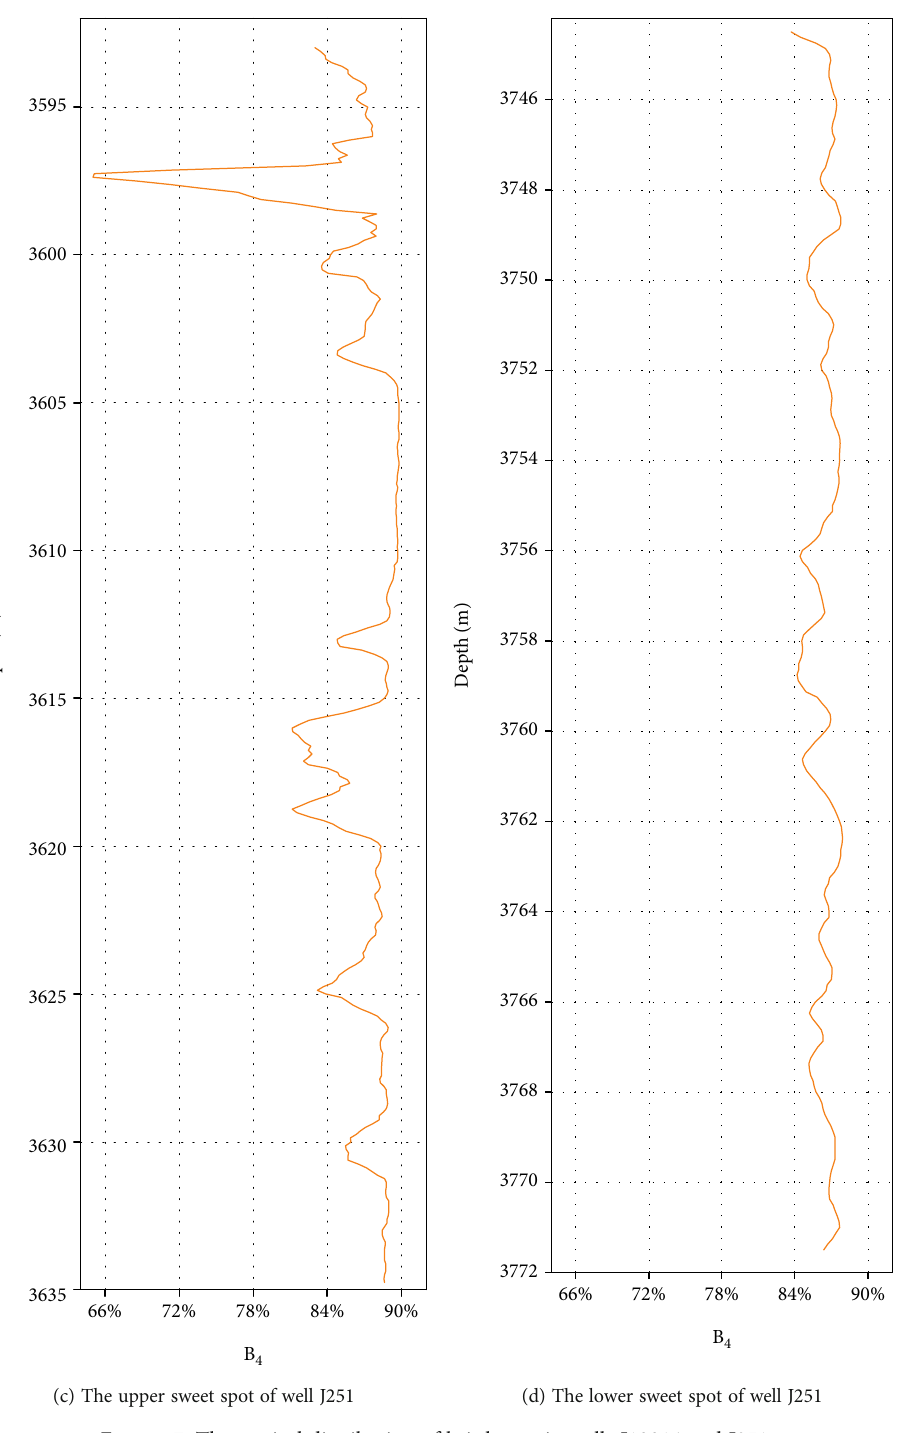
Figure 7: The vertical distribution of brittleness in wells J10014 and